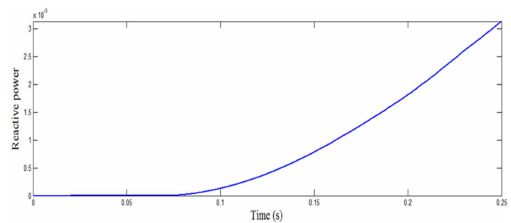
Figure 19. Real power from the bidirectional converter.